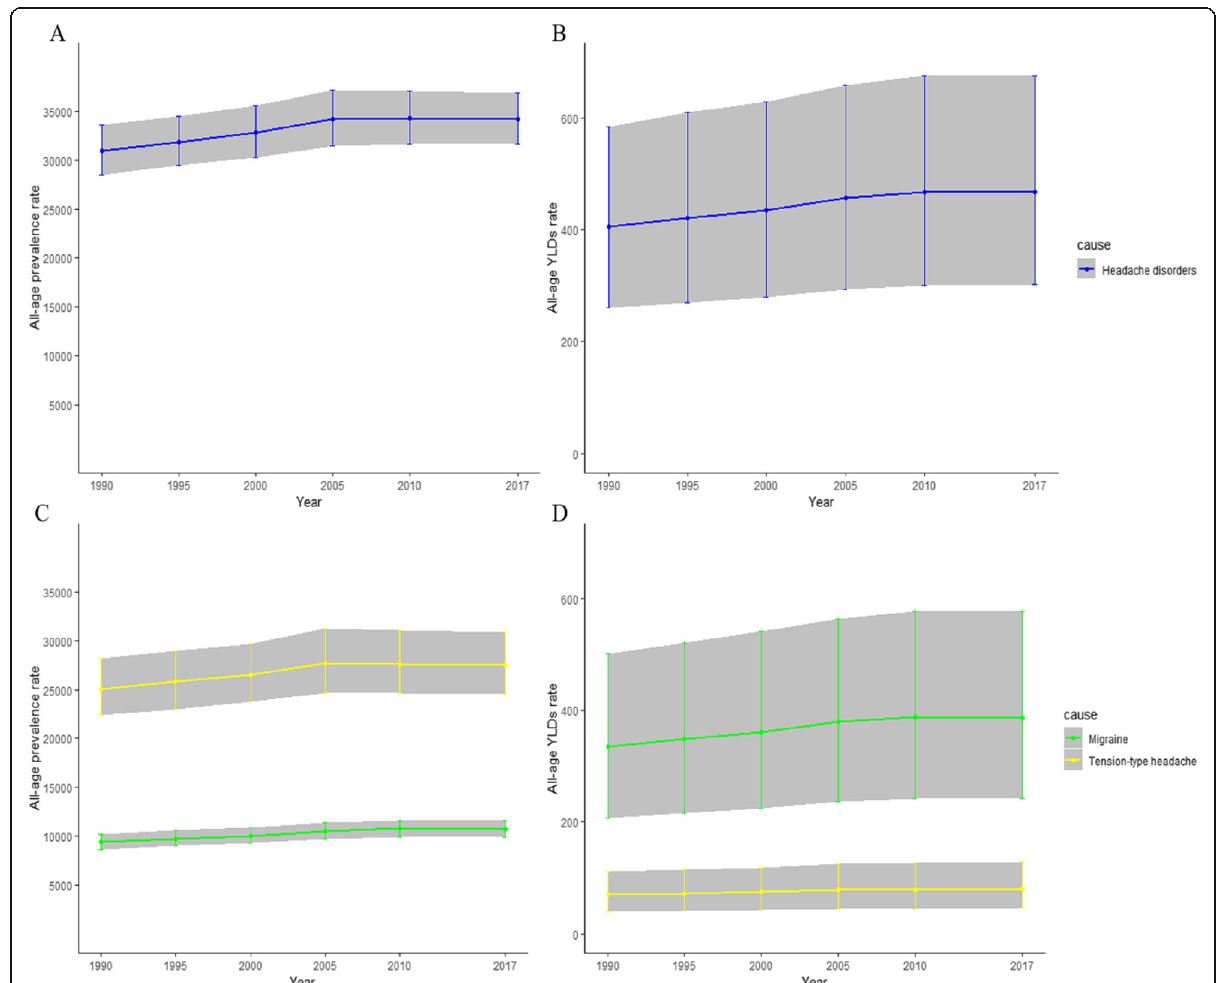
Fig. 1 The trends of headache disorders, migraine and tension-type headache in China from 1990 to 2017. Note: a the all-age prevalence rate from headache disorders; b The all-age YLDs rate from headache disorders; c the all-age prevalence rate from migraine and tension-type headache; d The all-age YLDs rate from migraine and tension-type headache. Abbreviation: YLDs: years of life lived with disability; TTH: tension-type